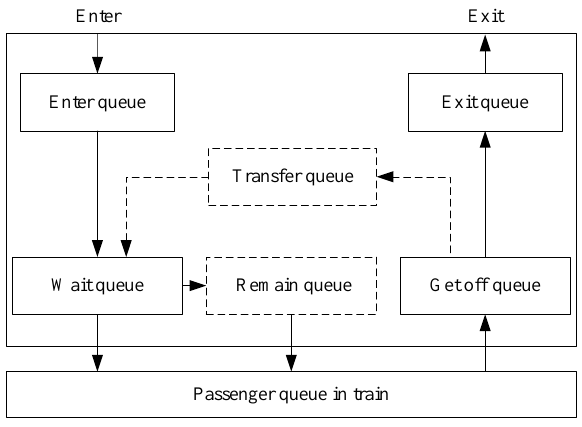
Figure 2. Queue models of passengers walking in